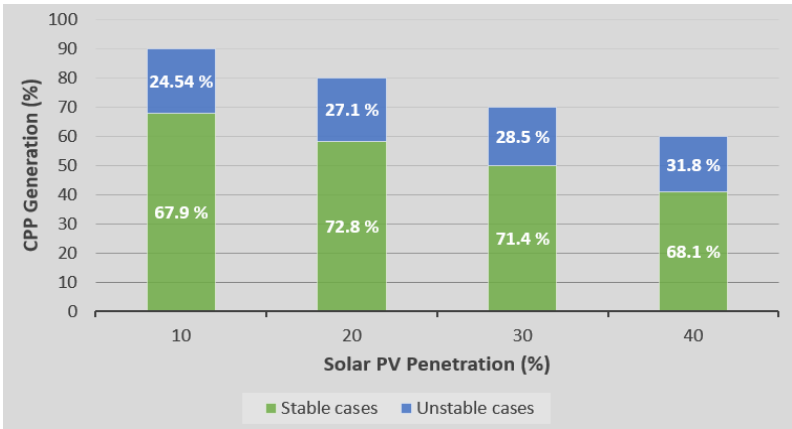
Figure 3. Summary of transient stability analysis for different PV penetration levels.